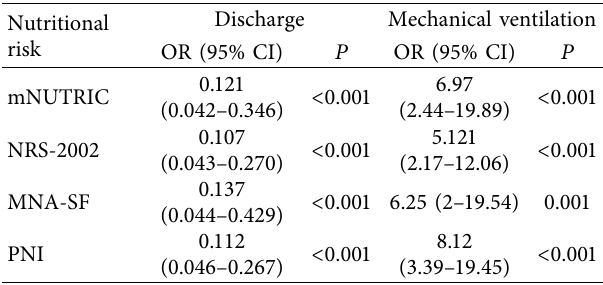
Table 3: Cross-tabulation of nutritional risk, hospital discharge, and need for mechanical ventilation.